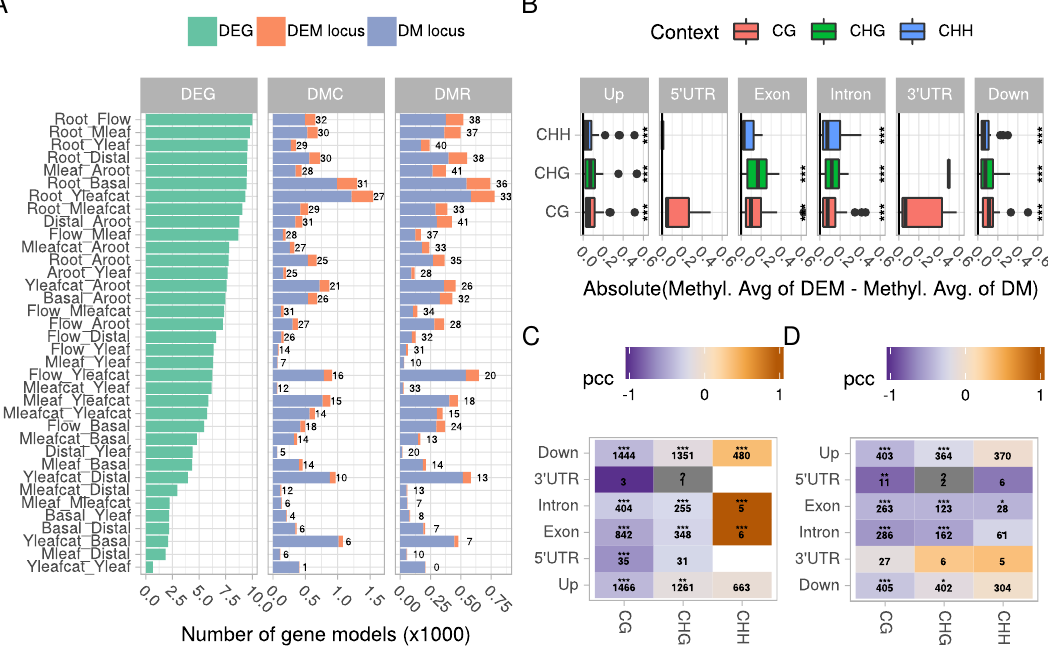
Figure 3. Relationship between differential methylation and differential expression. ( A ) number of differentially expressed genes (DEG), and number of gene models harboring at least one DMC or one DMR. A DM (differentially methylated) locus corresponds to a non-DEG with at least one DMC or DMR, while a DEM (differentially expressed and methylated) locus corresponds to a DEG with at least one DMC or DMR. Numbers correspond to the % of DEM/DM. Please note the differences in scale on the x -axis; ( B ) methylation differences of DEM or DM genes were averaged per comparison, context and gene feature. Differences between averages were calculated to highlight variation in methylation profiles between DEM and DM genes. The boxplots summarize data from all comparisons using absolute values of average differences. Asterisks denote statistical significant differences (Wilcoxon rank sum test, Bonferroni corrected p -values, ***: p < 0.001). ( C , D ) Pearson correlation coefficients (PCC) measuring the correlation between a gene expression log2FC and its methylation state (“.” p < 0.1, “*” p < 0.05, “**” p < 0.01, “***” p < 0.001) at the DMC and DMR levels, respectively. Numbers in cells correspond to the number of points used to calculate